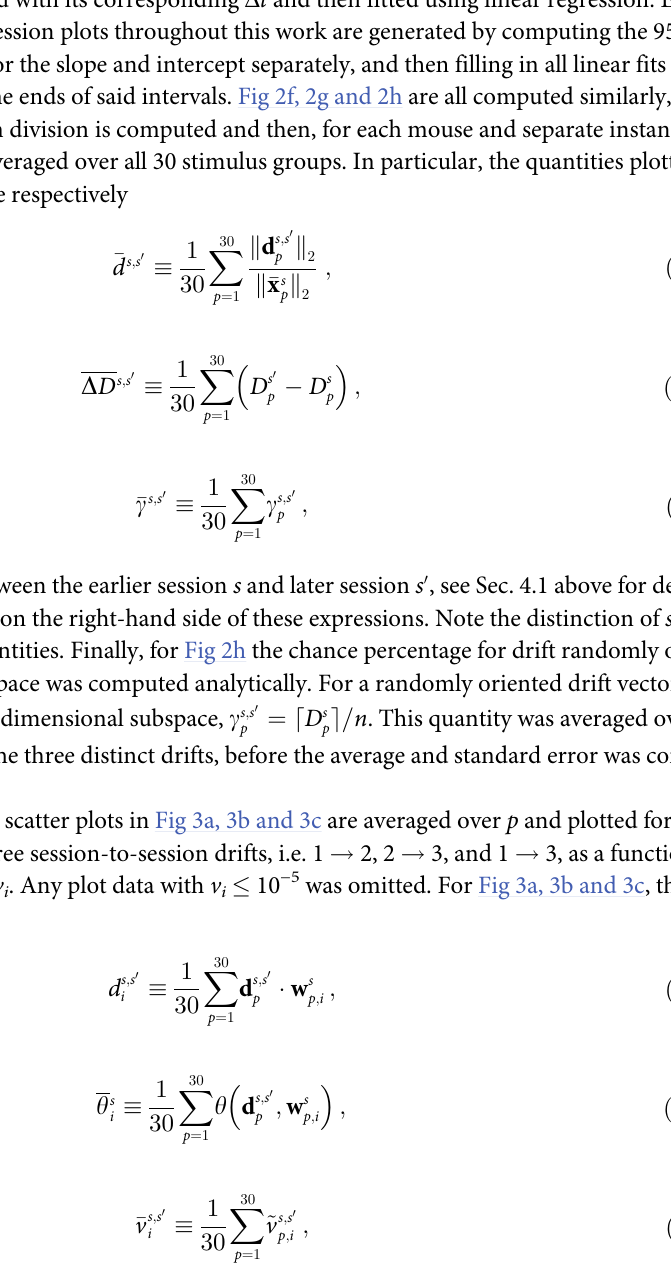
Fig 2e was generated using the same mean response vectors for each stimulus group, where now the pairwise angle between the mean response vectors belonging to the same group are computed. This is done for all 30 stimulus group and then the average of all between-session angles is computed, i.e.